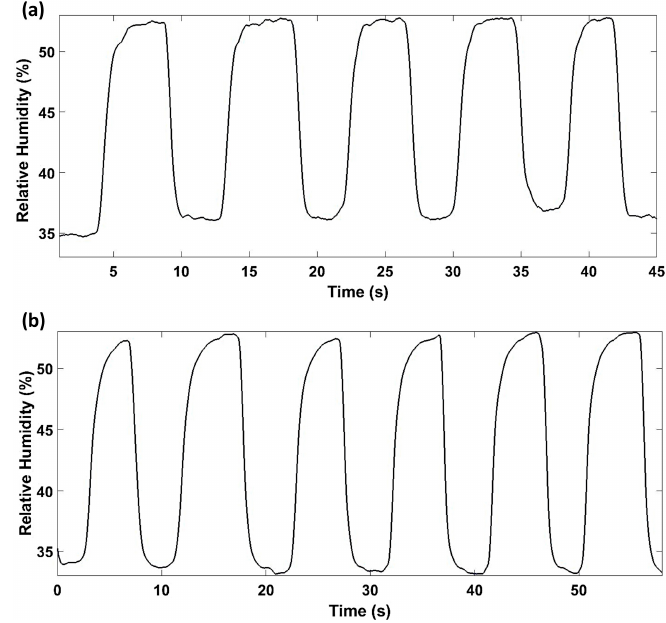
Figure 12. Response time of the optical device with ( a ) 19 periods, and ( b ) 38 periods.